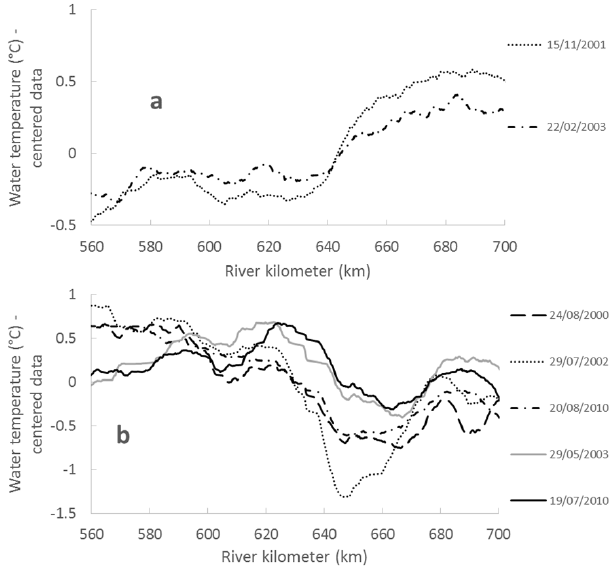
Figure 4. (a) Loire temperature profiles in winter extracted from the TIR images. (b) Loire temperature profiles in summer extracted from the TIR images. For each profile data were